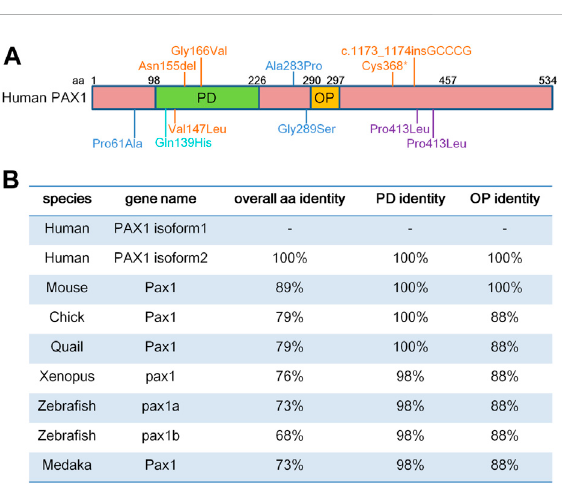
FIGURE 1 PAX1 is a highly conserved transcription factor. (A) Schematic representation of human PAX1 protein domains. It contains a highly conserved paired-box domain (PD) and an octopeptide domain (OP). Amino acid (aa) positions are indicated above. Locations of PAX1 mutations identi fi ed in human diseases are also marked. (B) Identityintheoverallaminoacidsequence,PDandOP domains between human PAX1 and PAX1 proteins from other species in National Center for Biotechnology Information